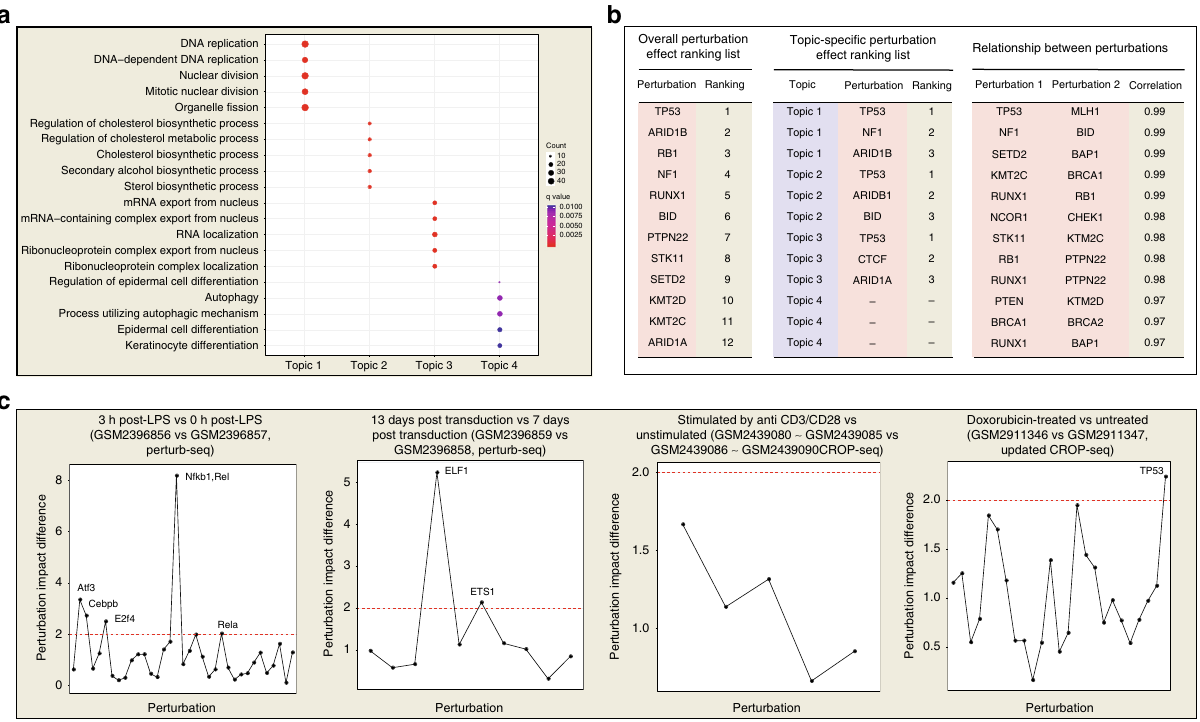
Fig. 3 An illustration result of MUSIC for single-cell CRISPR screening data analysis. We take the dataset of MCF10A cells treated with doxorubicin (GSM2911346) by the updated version of CROP-seq 8 as an example, as illustrated in ( a , b ). The overall perturbation effect ranking lists identi fi ed by MUSIC were also compared between cells with different treatment, as illustrated in ( c ). a The functional annotations of each topic derived from topic modeling for dataset GSM2911346. b The overall perturbation effect ranking list and the topic-speci fi c perturbation effect ranking list for dataset GSM2911346. c The differences of perturbation impact between different experimental conditions are demonstrated respectively for Perturb-Seq 5 and CROP-seq 7,8 data